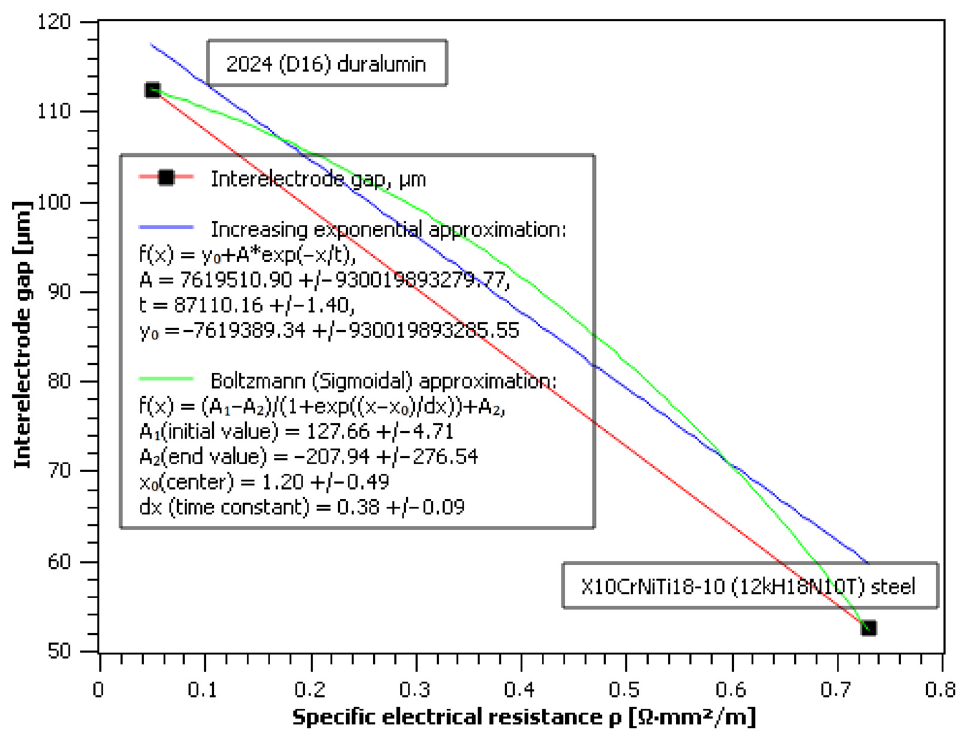
Figure 13. Dependencies and interpolations of the interelectrode gap values on specific electrical resistance ρ . at +20 ◦ C, for experimental values for X10CrNiTi18-10 (12kH18N10T) steel and 2024 (D16) duralumin, interpolation of increasing exponential approximation increasing exponential and Boltzmann (Sigmoidal) approximations.